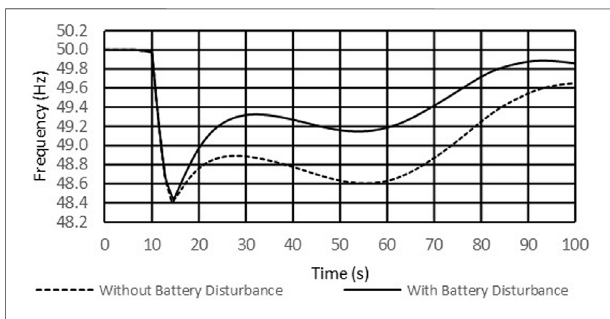
FIGURE 4 | Frequency response with and without battery bank in case of 275 MW